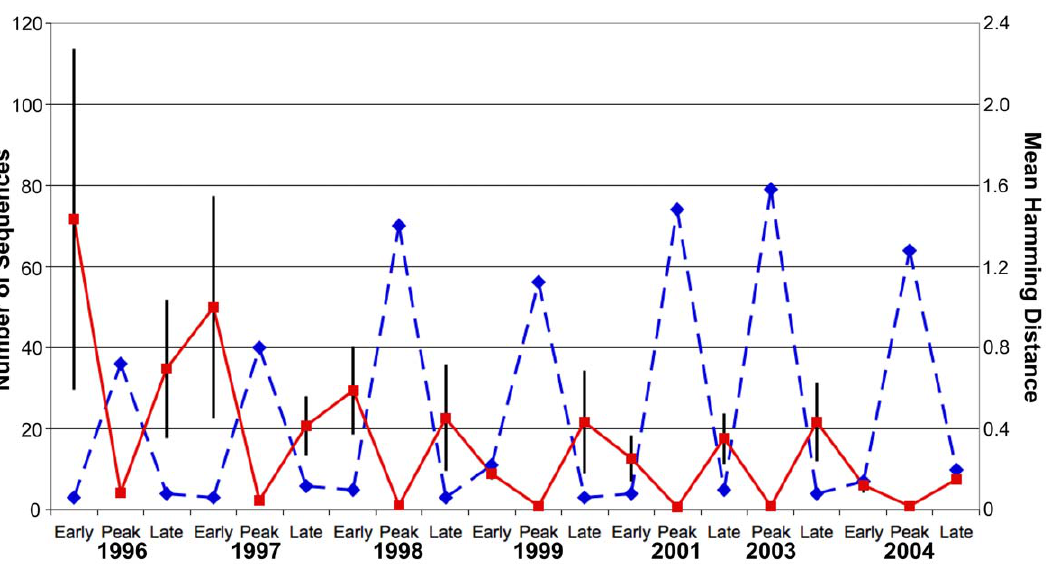
Figure 1. Sequence diversity and number of sequences over time. The mean Hamming distance of the aligned sequences, averaged across proteins, within each period of each season dipped during the peak epidemic periods (solid red line). Error bars indicate mean standard errors of mean sequence diversity across proteins. For every peak period, the standard error of mean Hamming distance was less than 1, too small to be visible here. The non-overlap of the error bars of the peak epidemic periods and the other periods indicates the statistical significance of the reduction in mean Hamming distance during the peak epidemic periods. The peaks in the total number of sequences sampled (dashed blue line) coincided with the dips in mean Hamming distance, suggesting that dominant sequence expansion during the peak epidemic period may have accounted for reduced diversity during the epidemic peak. The scale on the left applies to the number of sequences (dashed blue line).